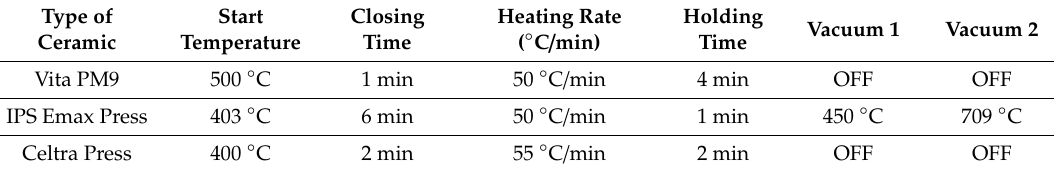
Table 3. Glazing parameters for each type of ceramic.